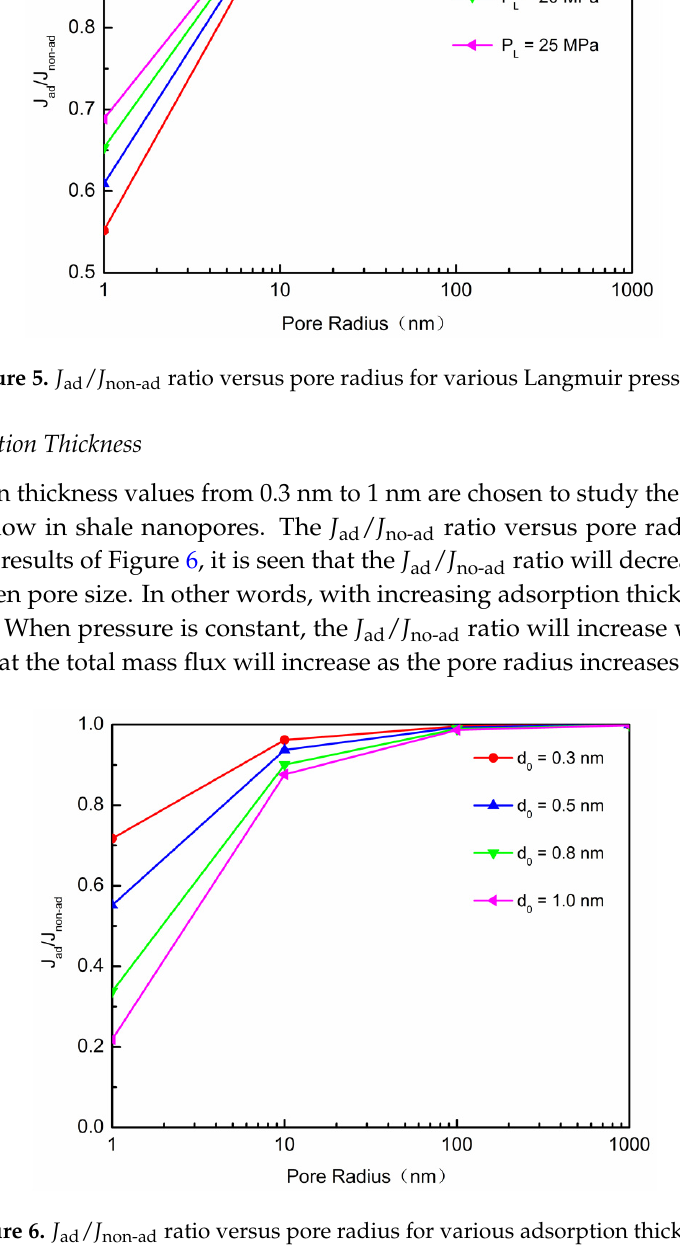
Figure 6. J ad / J non-ad ratio versus pore radius for various adsorption thickness.